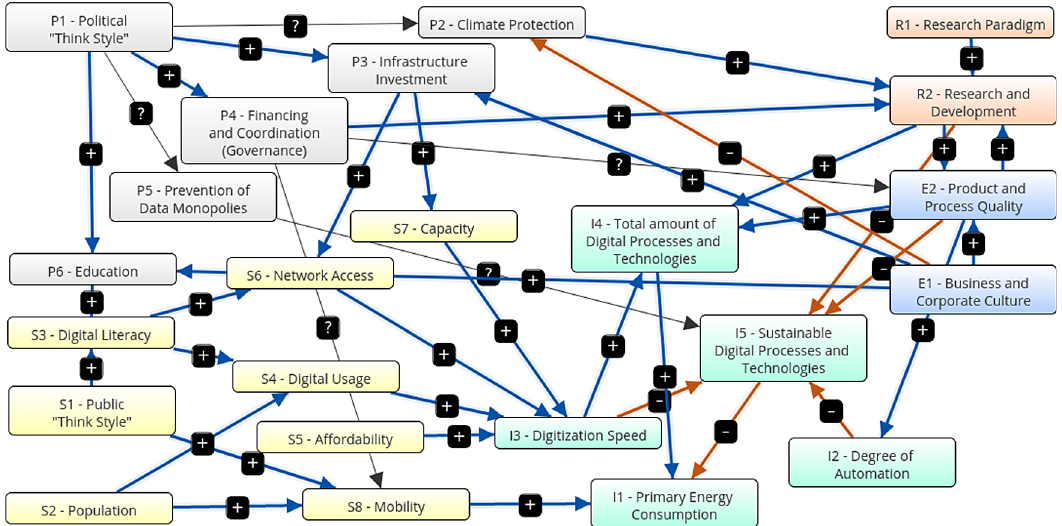
Figure 3. Graphical representation. Traditional growth-oriented scenario (Screenshot from Mental Modeler Software).